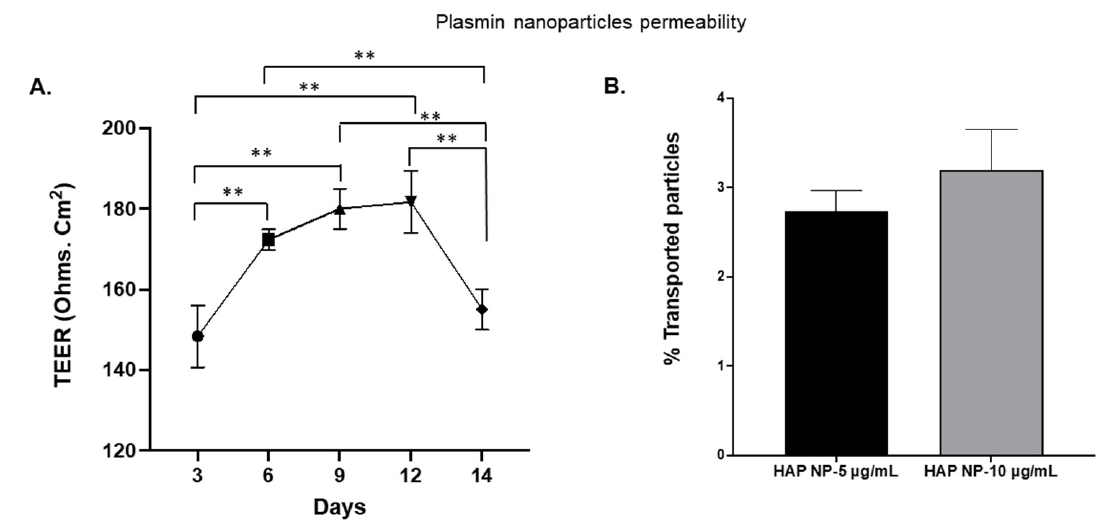
Figure 6. Vascular permeability of the particles was assessed in an in vitro transwell cell culture model. ( A ) TEER measurements showed the highest resistance after 9 days. ( B ) HAP NPs were incubated at 9 days and permeability of the particles was quantified compared to the initial particles concentration at the apical side. The particles showed minimal transport with less than 4% extravasation. n = 3 + SEM, ** p < 0.01.